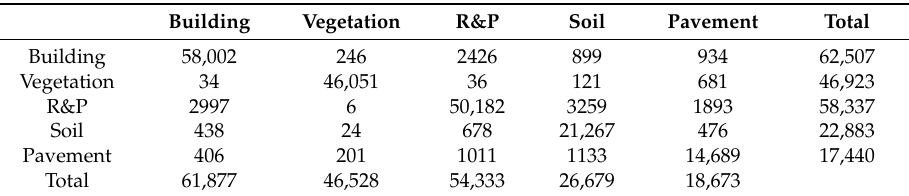
Table 6. Confusion matrix for the proposed method, where the reference is shown as Figure 15. The values in the table indicate the numbers of pixels.